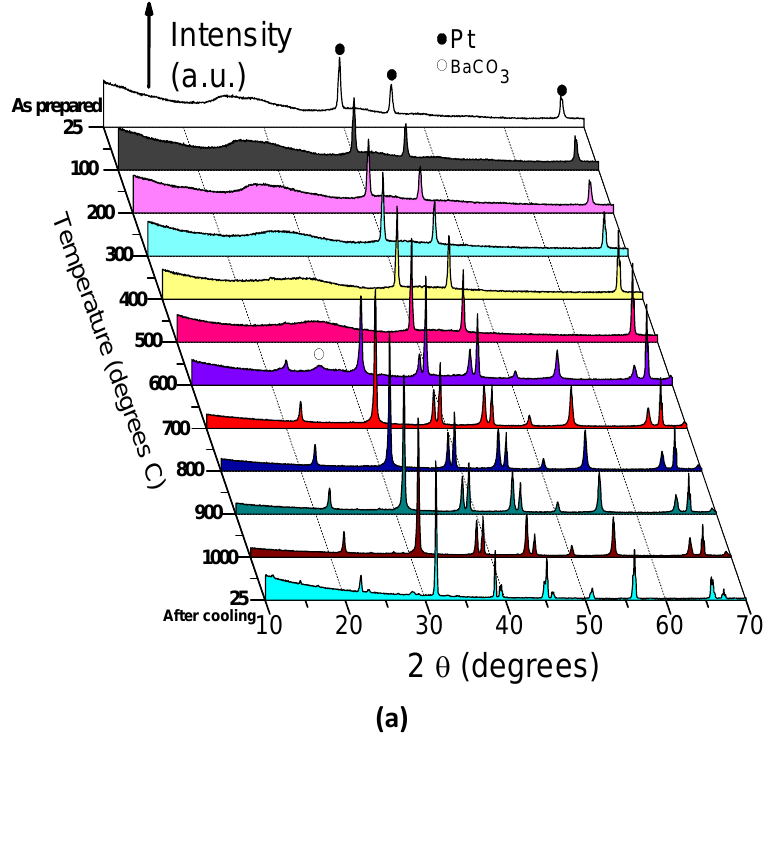
Figure 4. HT-XRD patterns of BaTiO related to the platinum ribbon are noted with a